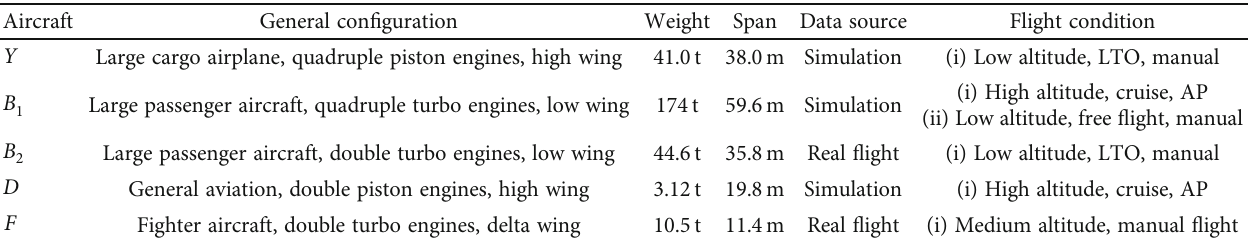
Figure 1: Aircraft motion equations and the fault detection scheme formulated in this paper. Table 1: Di ff erent aircraft and fl ight conditions adopted in this